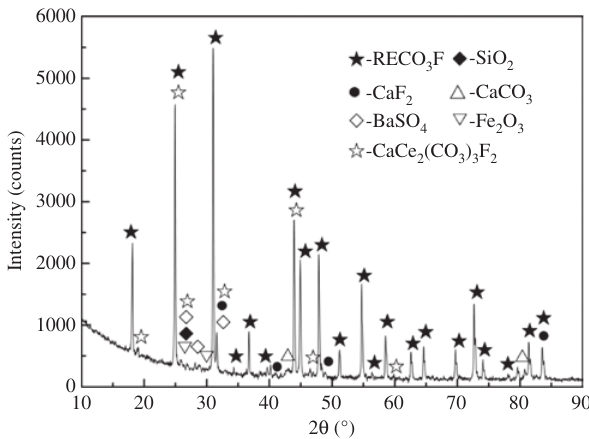
Figure 2: X-ray diffraction pattern of bastnaesite